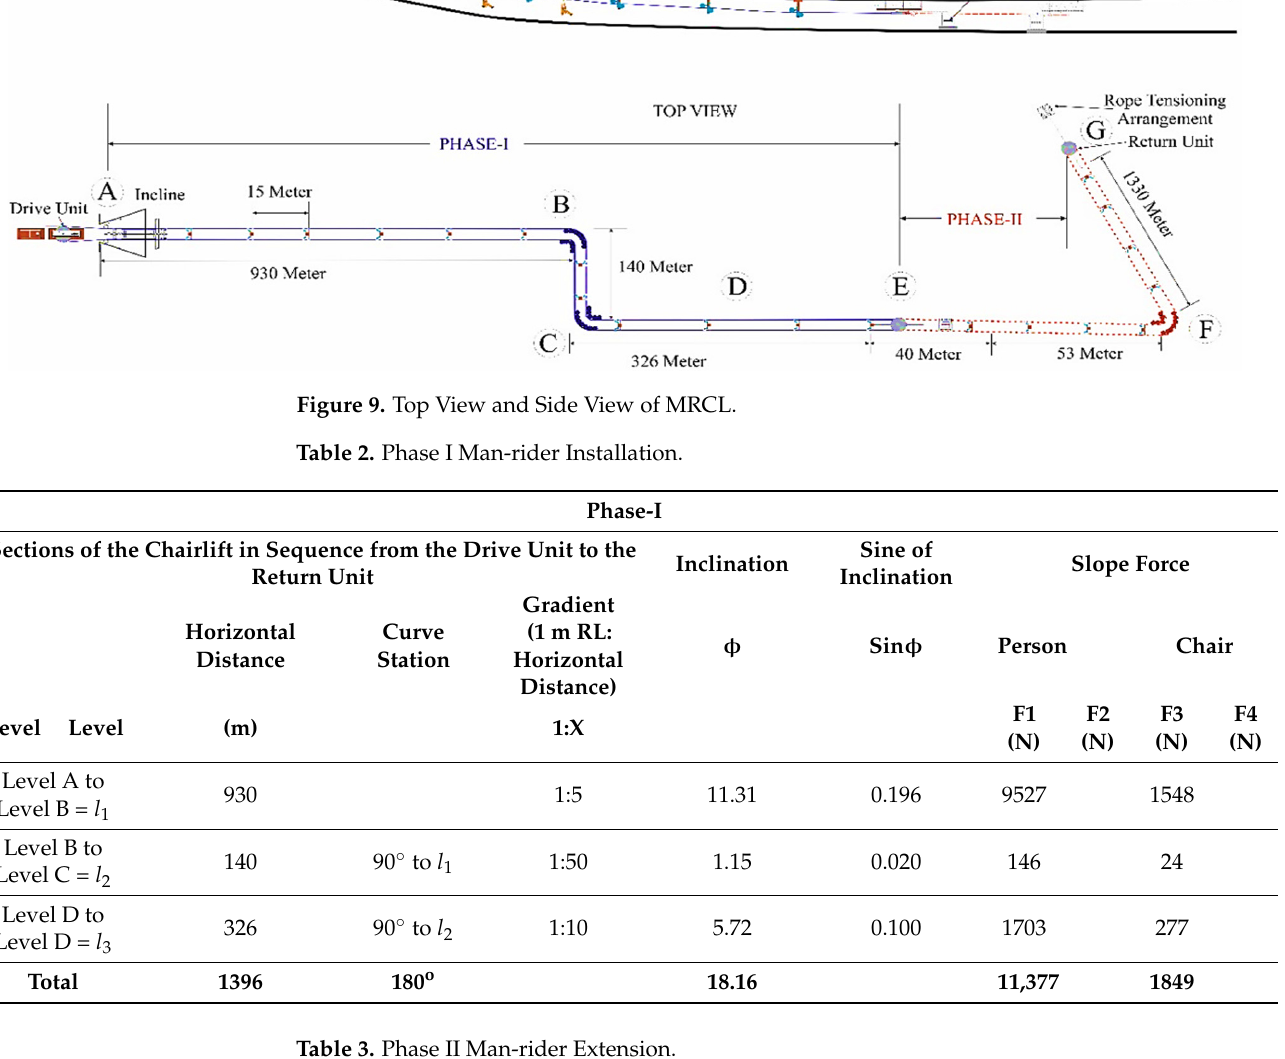
9 of 19 Figure 8. Rope Tensioning Unit. Weight of counter weight W C = 1500 kgf; Force on tensioning rope due to counter weight: F Cw = W C × 9.81 (23) Forces acting on tensioning rope: F WR = F CW + F HC (24) Minimum breaking force of the tensioning rope B F : B F = 167,000 N for 16 mm steel wire rope; B F = 191,000 N for 18 mm steel wire rope. Factor of safety of tensioning rope: F.S TR = Ultimate strength/Working stress = B F /F WR